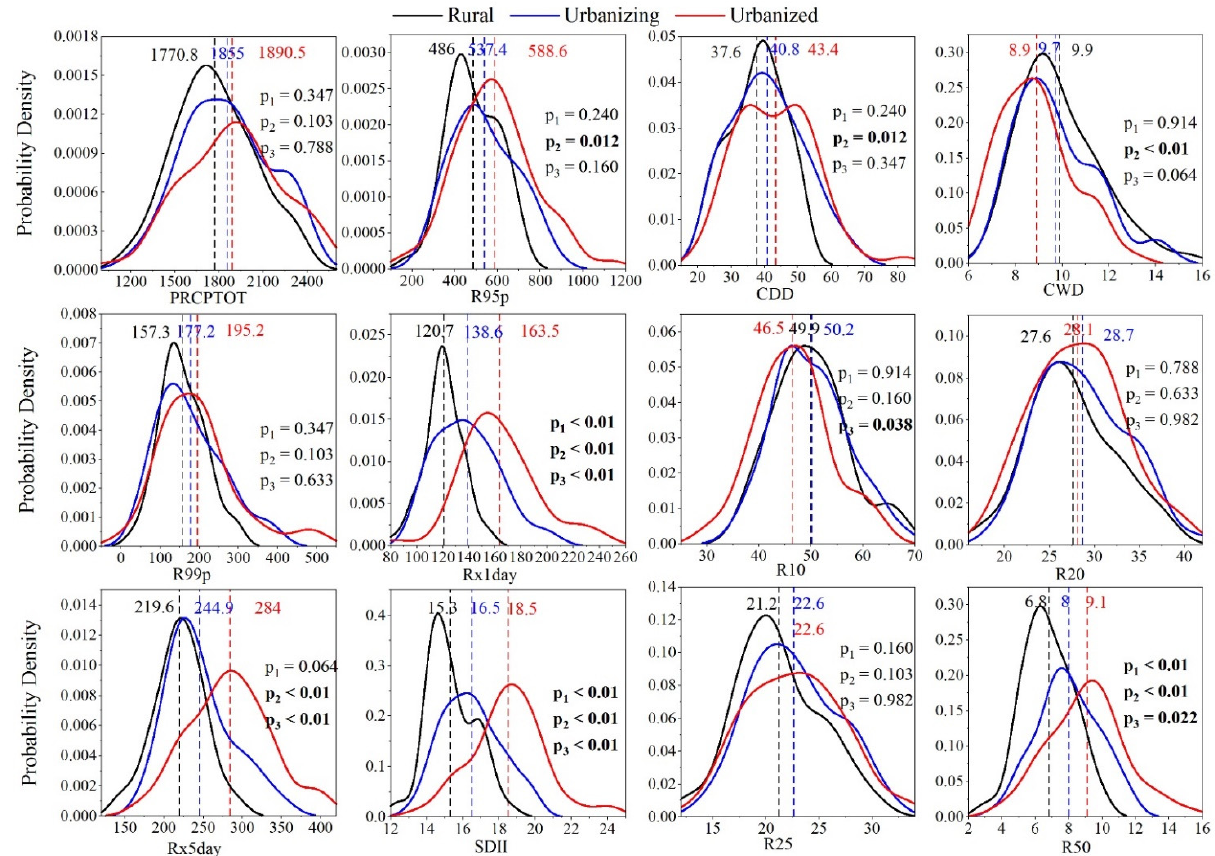
Figure 5. Probability density functions of extreme precipitation indices for the rural (black line), urbanizing (blue line), and urbanized (red line) areas over the PRD metropolitan region during 1961–2017. The dashed lines represent the mean values of extreme precipitation indices for different parts during 1961–2017. The p values indicate whether the differences in the two distributions for precipitation extremes are significant, based on the two-sample Kolmogorov–Smirnov test. The p 1 value is estimated based on the rural and urbanizing series, p 2 on the rural and urbanized series, and p 3 on the urbanizing and urbanized series.